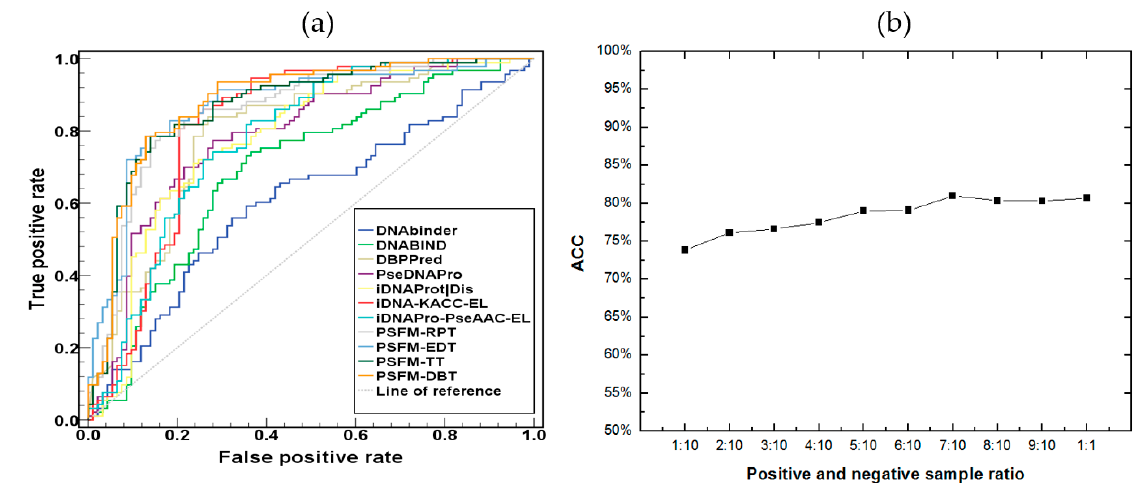
Figure 3. ( a ) The ROC curves of various methods on the independent dataset PDB186. ( b ) The performance of PSFM-DBT on the independent dataset with different ratios of positive samples.